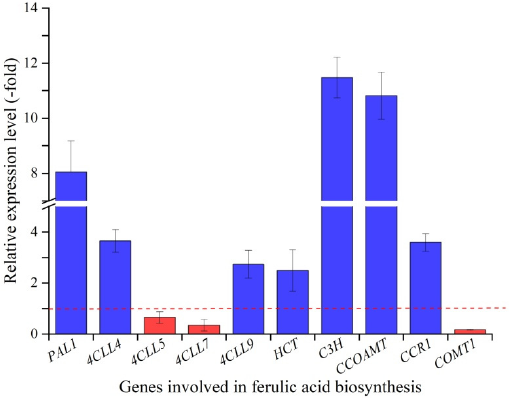
Figure 4. Expression levels of ten genes related to ferulic acid biosynthesis in A. sinensis . Histo- grams show the relative expression level in response to 15 °C compared to 22 °C. The same below.